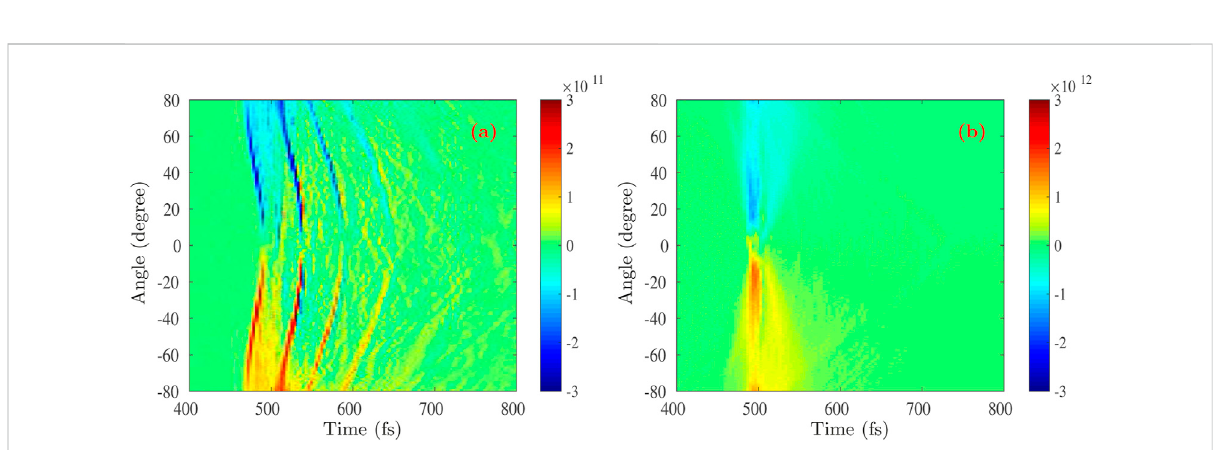
FIGURE 2 The collected electromagnetic fi eld by a semi-circle over time for both of the fl at target (A) and TTT (B)